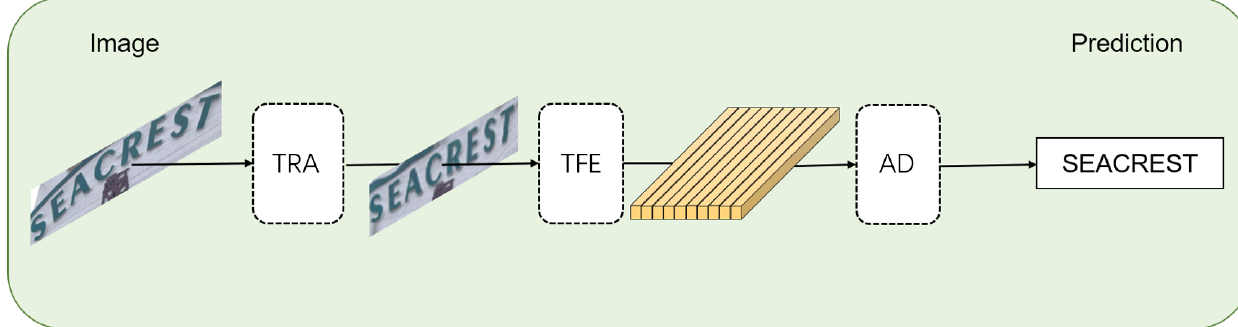
Figure 2. The overview of three-stage text recognizer, TRIG. The first stage is transformation (TRA), which is used to rectify text images. The second stage is a Transformer Feature Extractor (TFE), aiming to extract effective and robust features and implicitly model context. The third stage is an attention decoder (AD), which is used to decode the sequence of features into characters. Text can be predicted from the image by